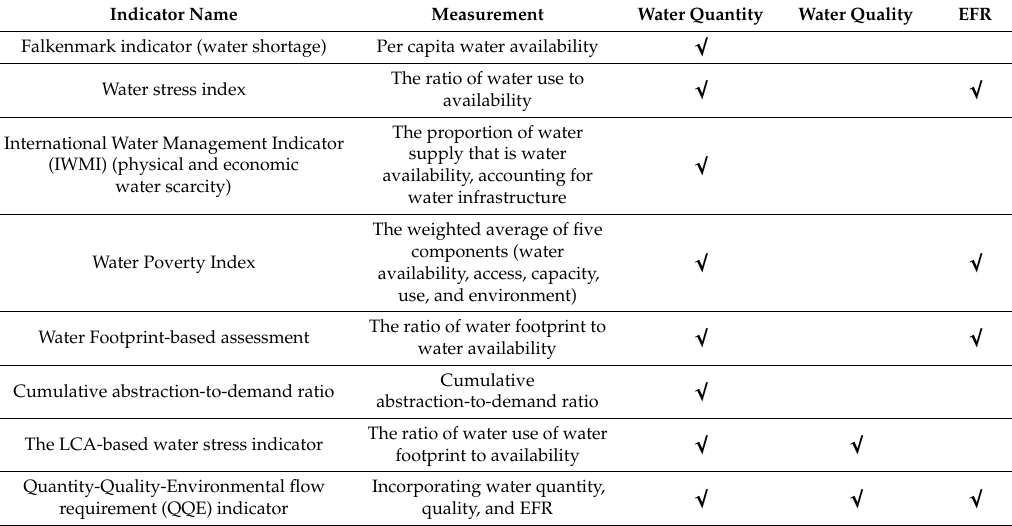
Table 3. Summary of the characteristics of physical water scarcity indicators